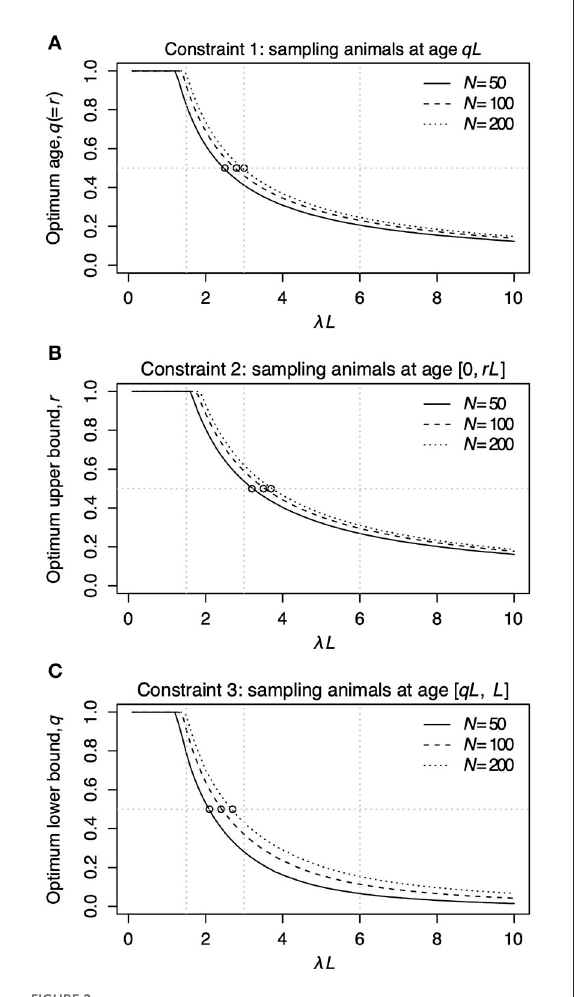
FIGURE2 The relationship between λ L and the optimum age parameter value for Constraints 1 (A) , 2 (B) , and 3 (C) . In each panel, the solid line represents N = 50, the dashed line represents N = 100, and the dotted line represents N = 200. The horizontal line in (A) represents r = q = 0.5 for Constraint 1. The horizontal line in (A) represents r = 0.5 for Constraint 2. The horizontal line in (A) represents q = 0.5 for Constraint 3. The open circles in (A–C) denote the points where the optimum sampling age parameters are 0.5. Vertical panel lines (A–C) are drawn at λ L = 1.5, λ L = 3.0, and λ L = 6.0, which are the values used in the sampling simulation in Table